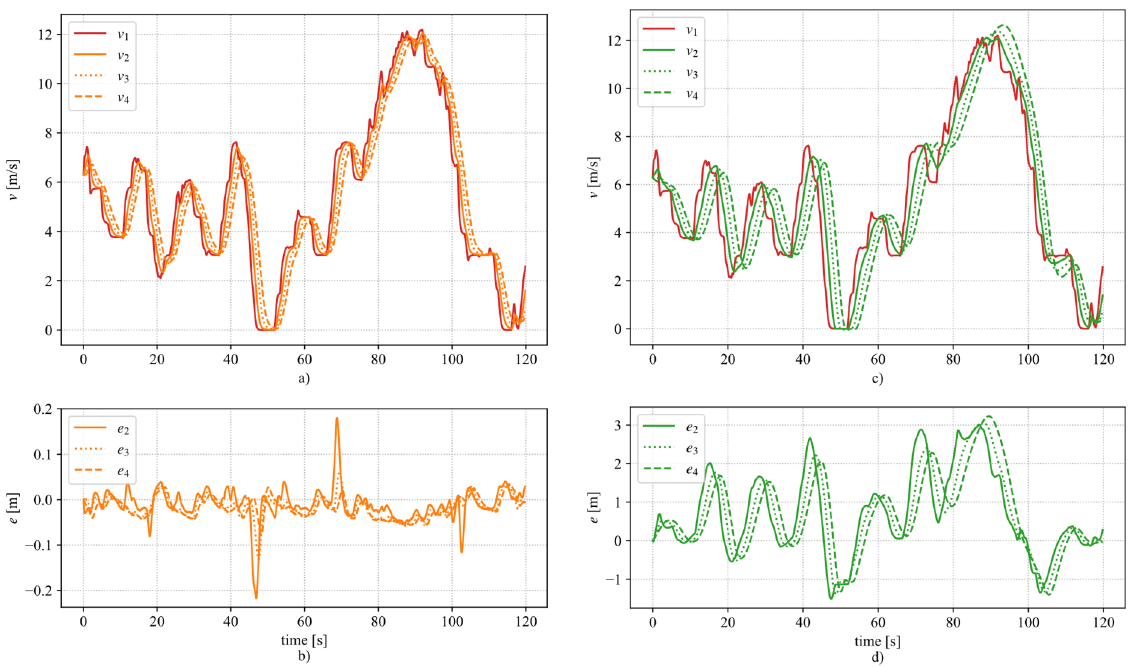
Figure 7. Platoon consisting of three agent-controlled vehicles and a leader vehicle. ( a , b ) show the velocities v and the respective distance errors e in case the follower vehicles were P-EM-RL-controlled; ( c , d ) show v and e in case the follower vehicles were